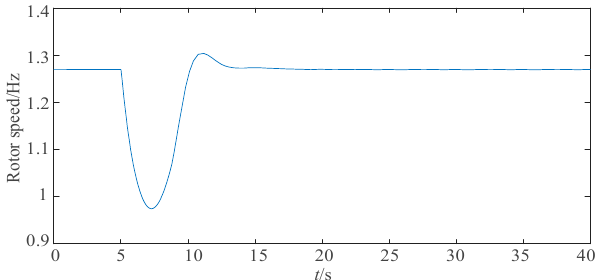
Figure 12. Power change diagram of energy storage.